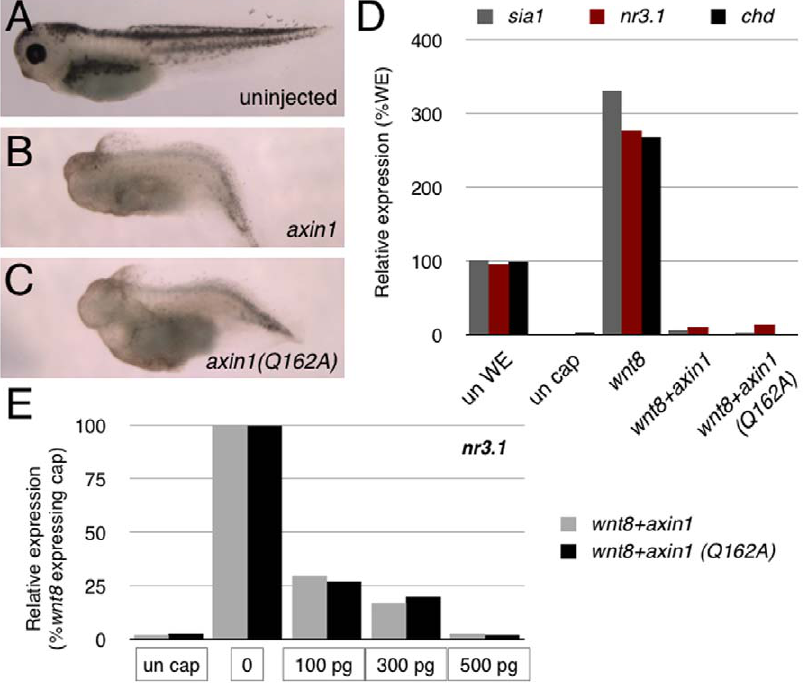
Figure 3. Overexpression of Axin1 Q162A blocks axis formation and Wnt signaling in Xenopus embryos. ( A–C ) Representative phenotypes of stage 40 control uninjected embryos ( A ), axin1 -injected embryos (500 pg), ( B ) and axin1(Q162A) -injected embryos (500 pg) ( C ). ( D ) Representative realtime RT-PCR of sia1 , nr3.1 and chd expression in control whole embryos (un WE), control animal caps (un cap) and caps injected with wnt8 (1 pg) and Axin constructs (500 pg). ( E ) Realtime RT-PCR of nr3.1 expression in animal caps injected with wnt8 and different doses of Axin constructs (100 pg, 300 pg, 500 pg; indicated below sets of bars).